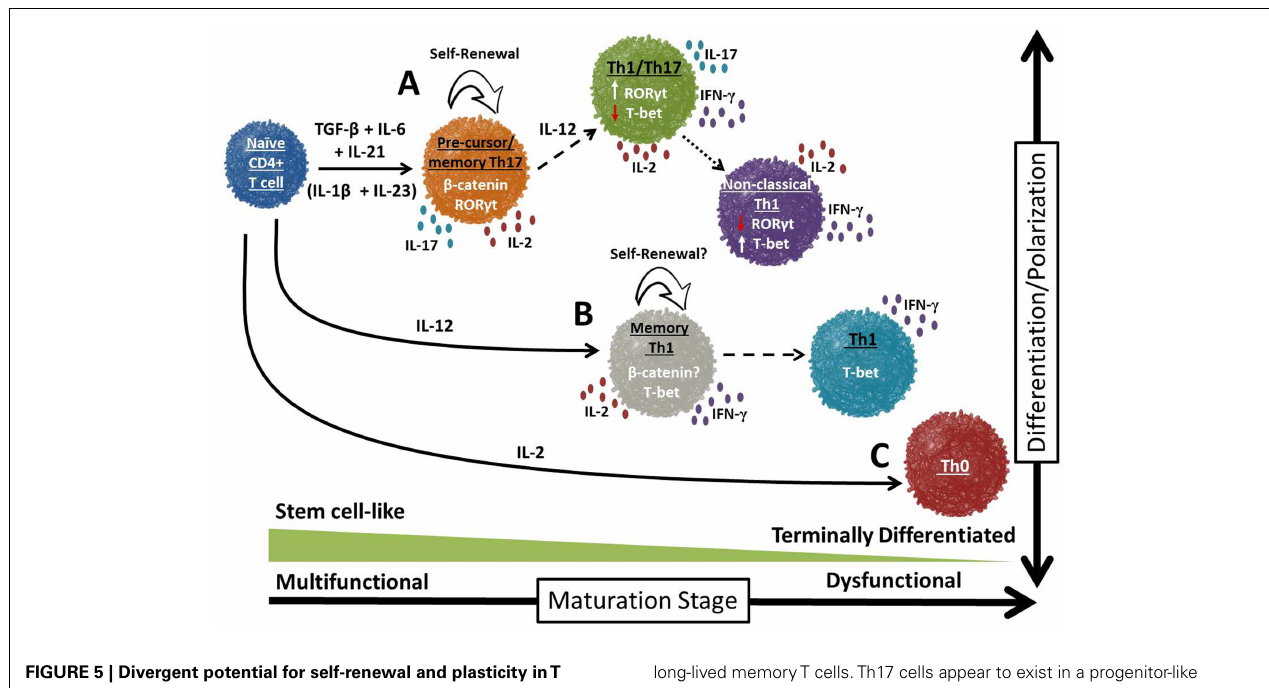
FIGURE 5 | Divergent potential for self-renewal and plasticity inT cell subsets. Over time, the majority of CD4 + T cells differentiate into terminally differentiated effectors that possess short-lived immune responses to tumor antigen. However, a small proportion of these cells will enter into a self-renewing pool, resulting in the generation of